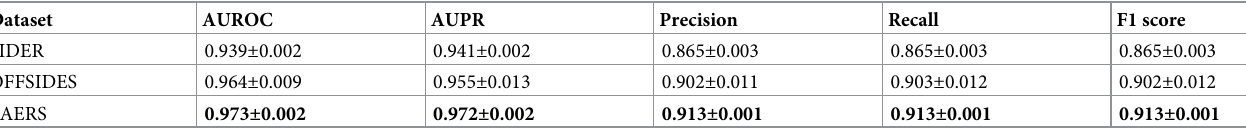
Table 6. Comparing the performance of the GCNMLP on the three datasets. Dataset